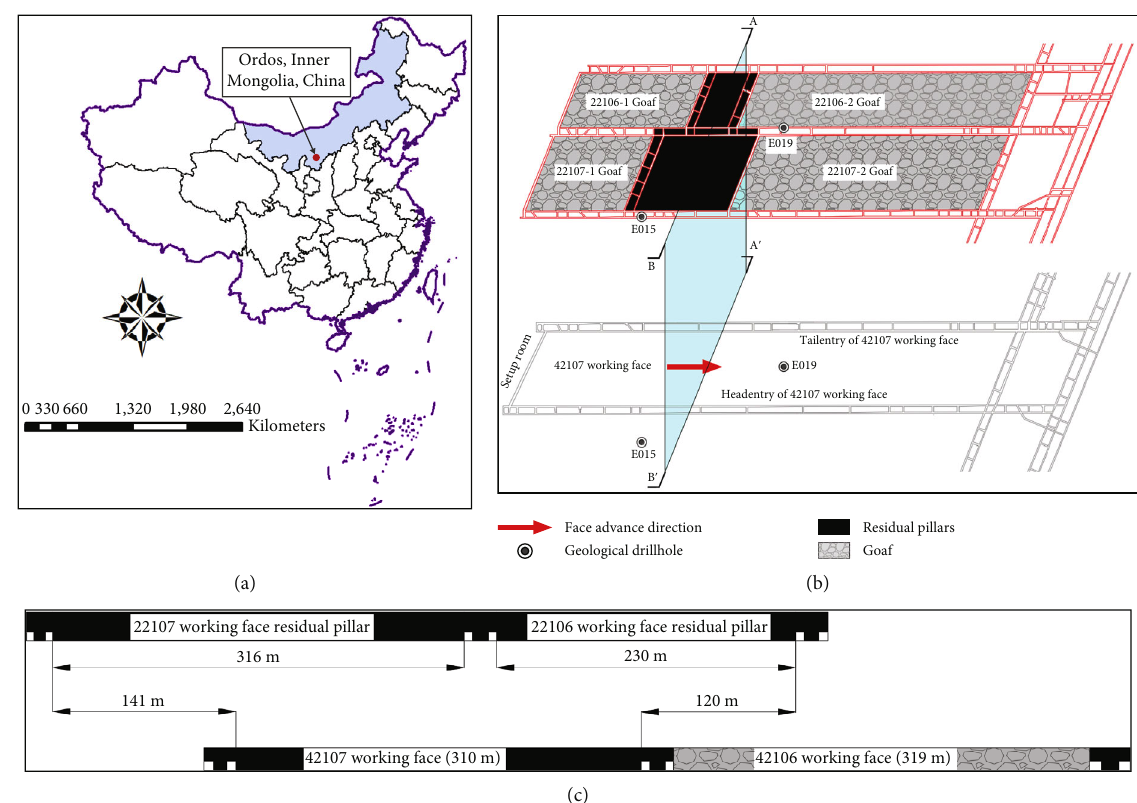
Figure 1: Layout of working faces. (a) Location of Bultai coal mine. (b) Spatial relationship of working faces. (c) AB-A ′ B ′ cross-section